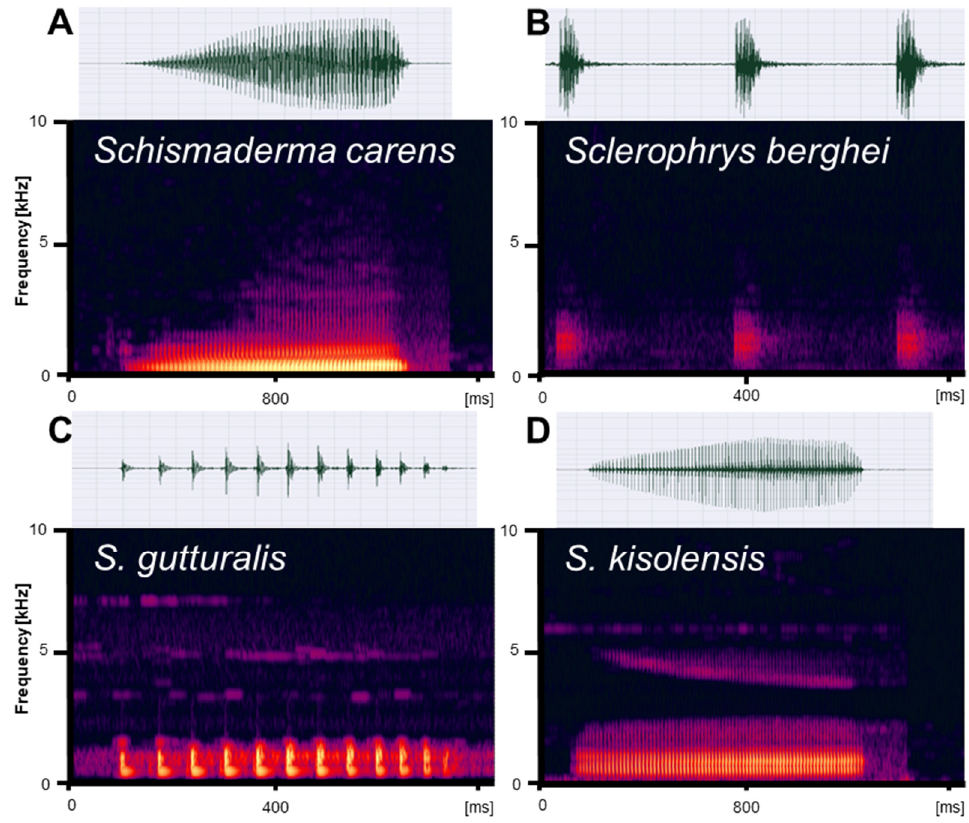
Figure 5. Advertisement calls of Bufonidae in Rwanda. ( A ) Schismaderma carens , ( B ) Sclerophrys berghei , ( C ) Sclerophrys gutturalis , ( D ) Sclerophrys kisoloensis . Calls are shown as representative spectrograms and oscillograms.